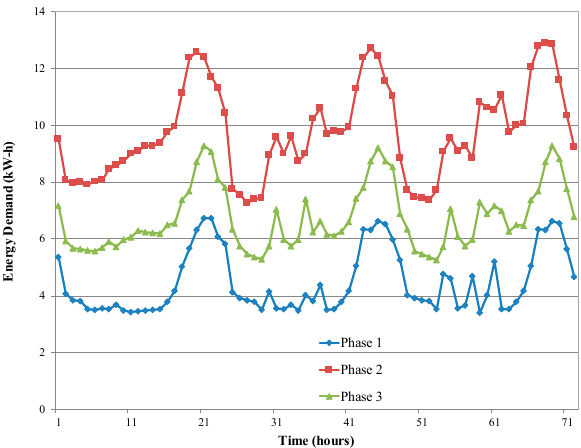
Figure 3. Example hour demands for 10 single-phase loads in 72 h [19].